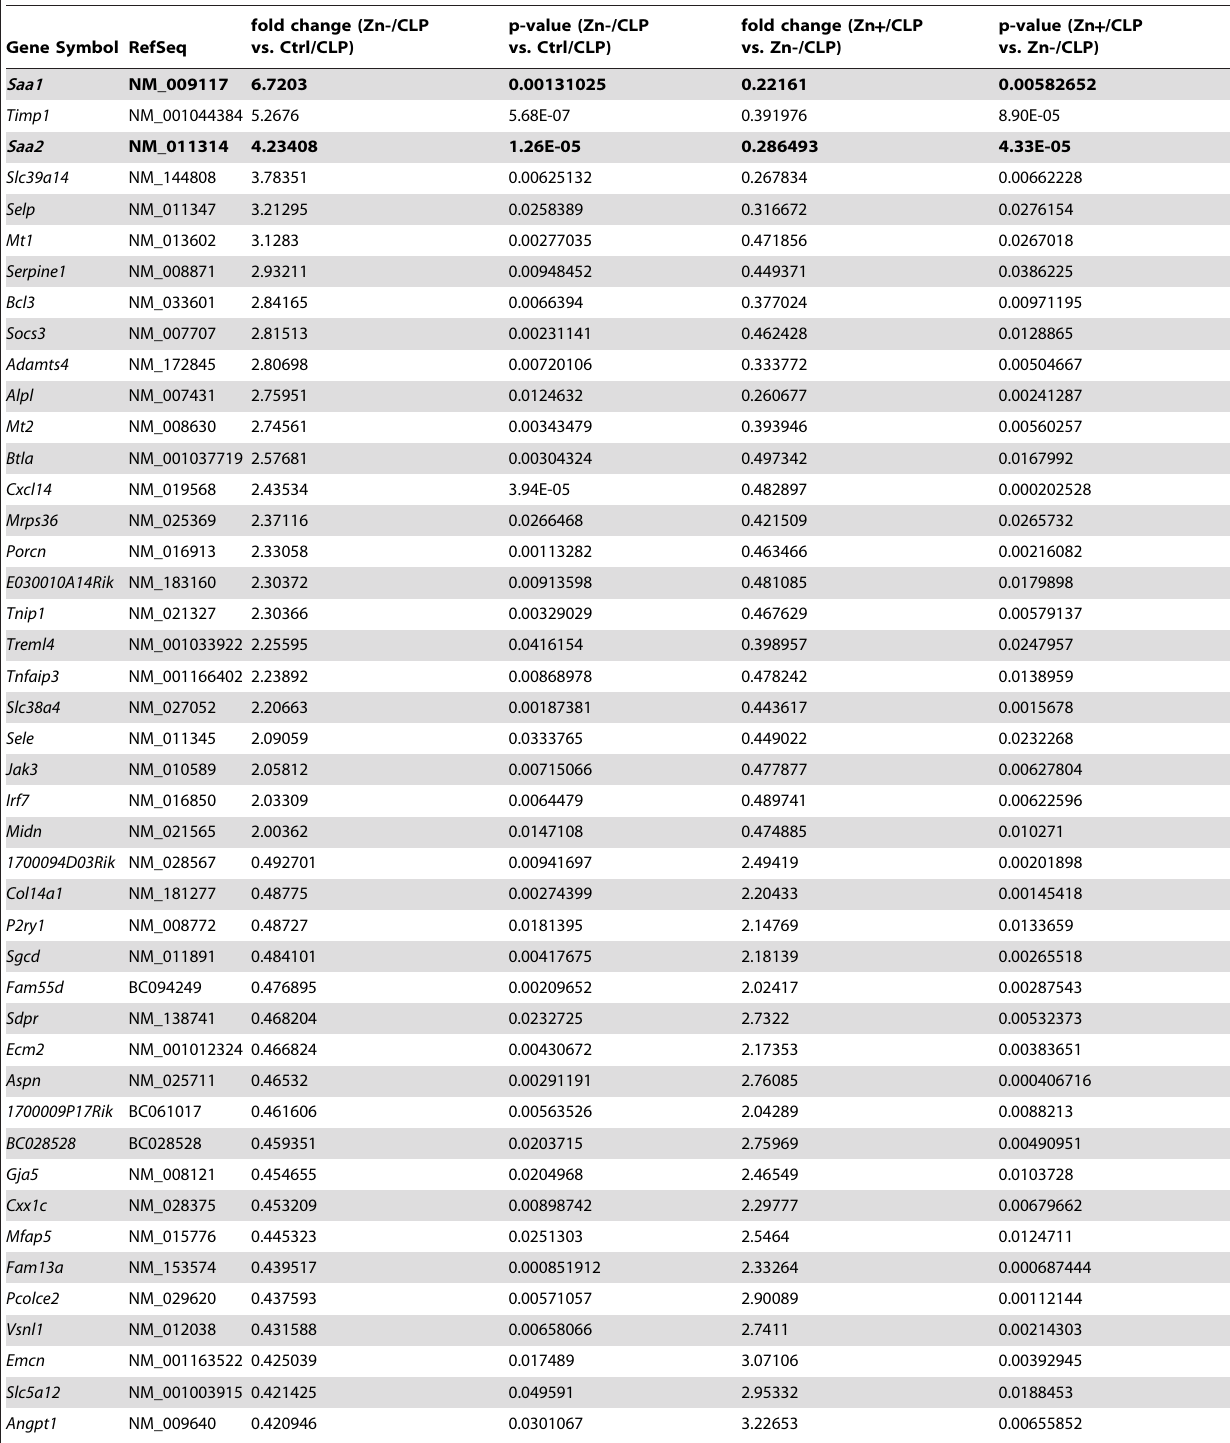
Table 1. The Zn-responsive gene list in the setting of CLP-induced sepsis.